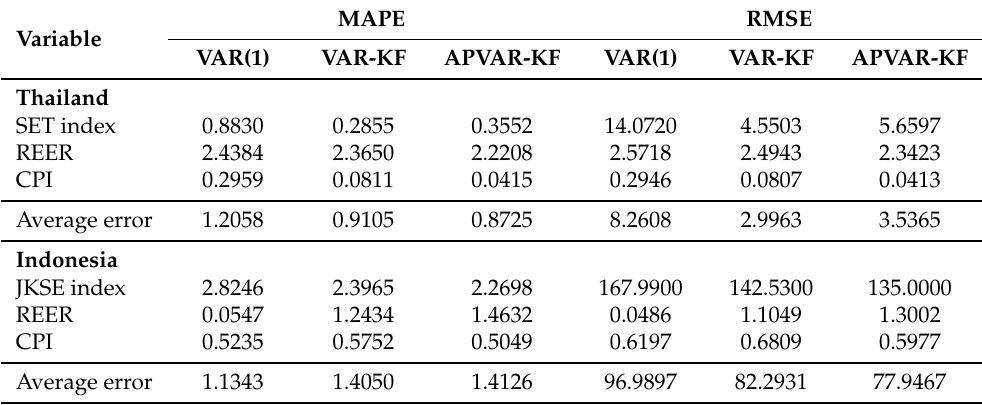
Table 6. Mean absolute percentage errors and root mean square errors of May